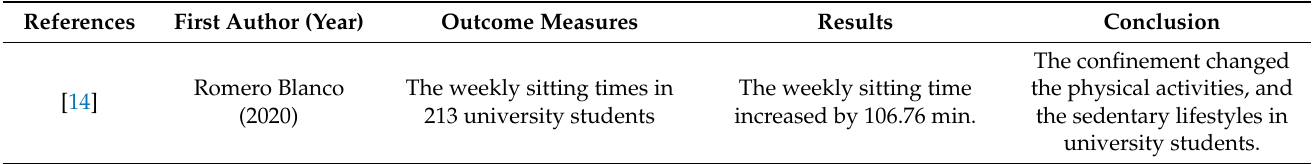
Table 2. Impact of the COVID-19 lockdown in healthy